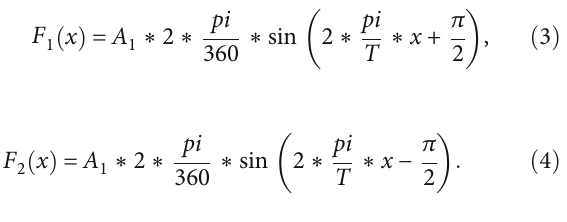
lows: L 1 = 0 : 2 m and L 2 = 0 : 2